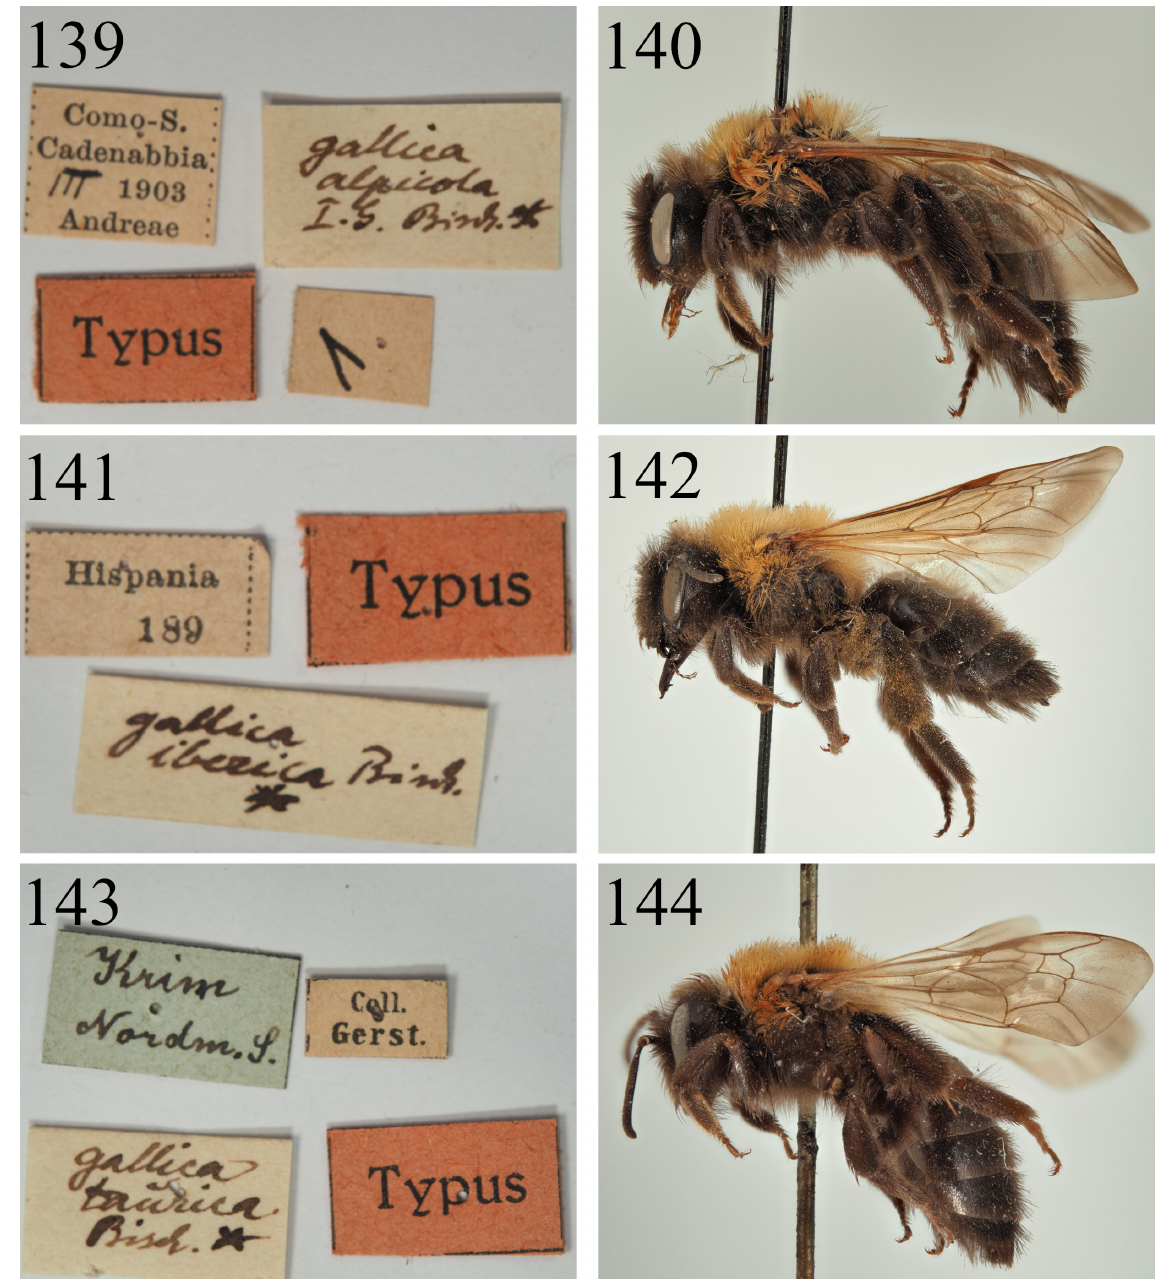
Figs 139–144. 139–140 . Andrena gallica alpicola Bischoff, 1922, ♀, syntype (ZMHB). 139 . Label, detail. 140 . Profile. 141–142 . Andrena gallica iberica Bischoff, 1922, ♀, syntype (ZMHB). 141 . Label, detail. 142 . Profile. 143–144 . Andrena gallica taurica Bischoff, 1922, ♀, syntype (ZMHB). 143 . Label, detail. 144 .